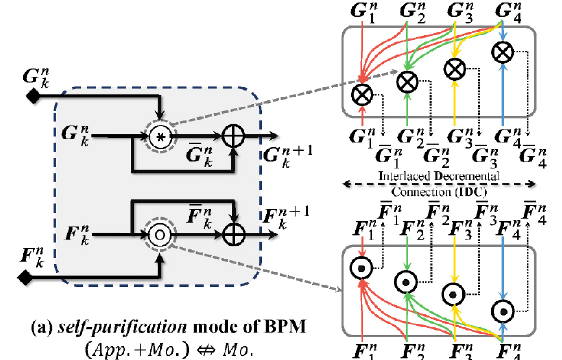
Fig. 9 Self-purification strategy (a) and the proposed bidirectional purification strategy (b) (the latter repeats Fig. 5(c) for convenience). ⊕ , ⊗ , and (cid:12) denote element-wise addition, multiplication, and concatenation,